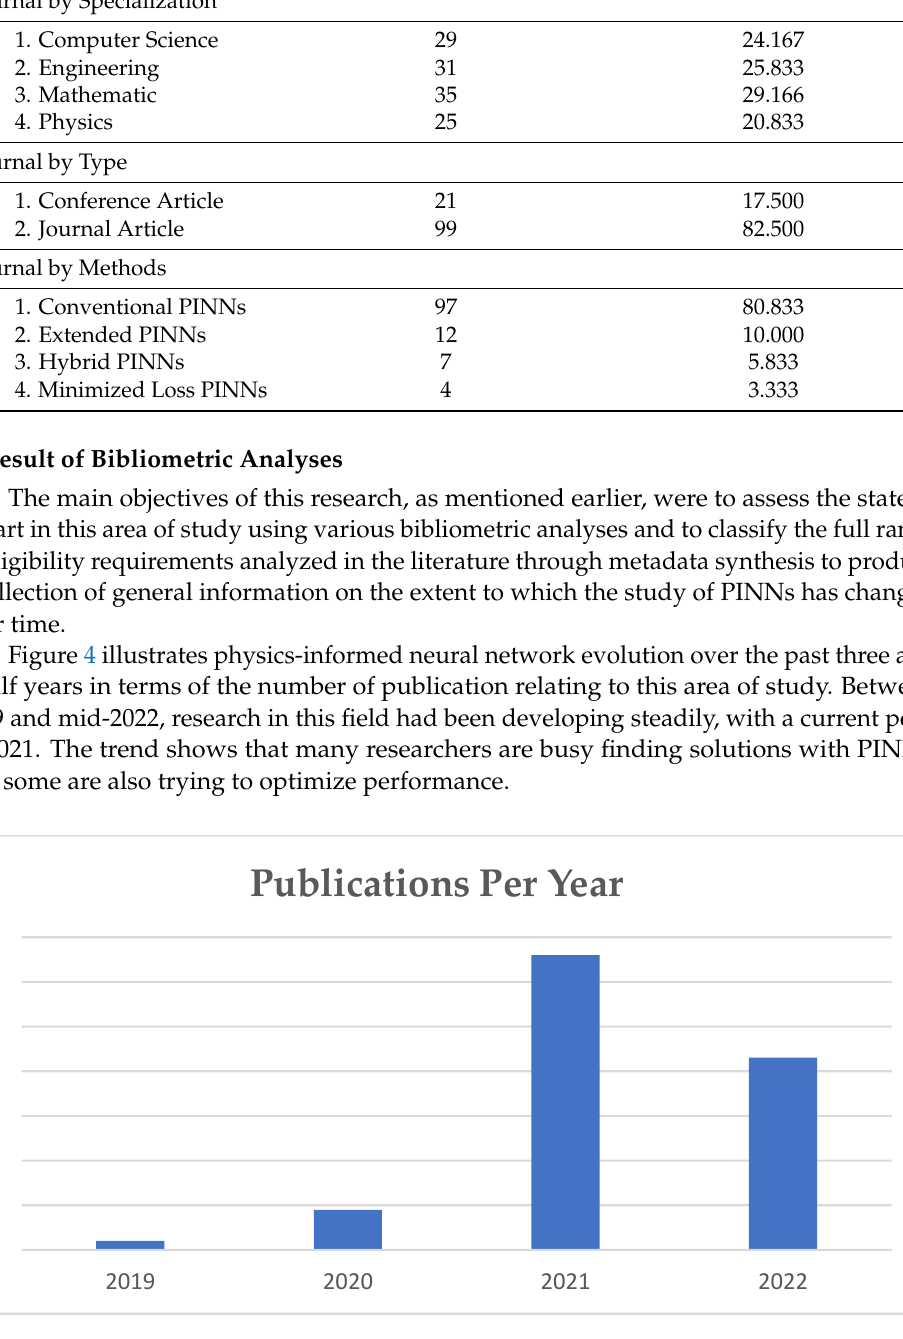
Figure 4. Publications per year.